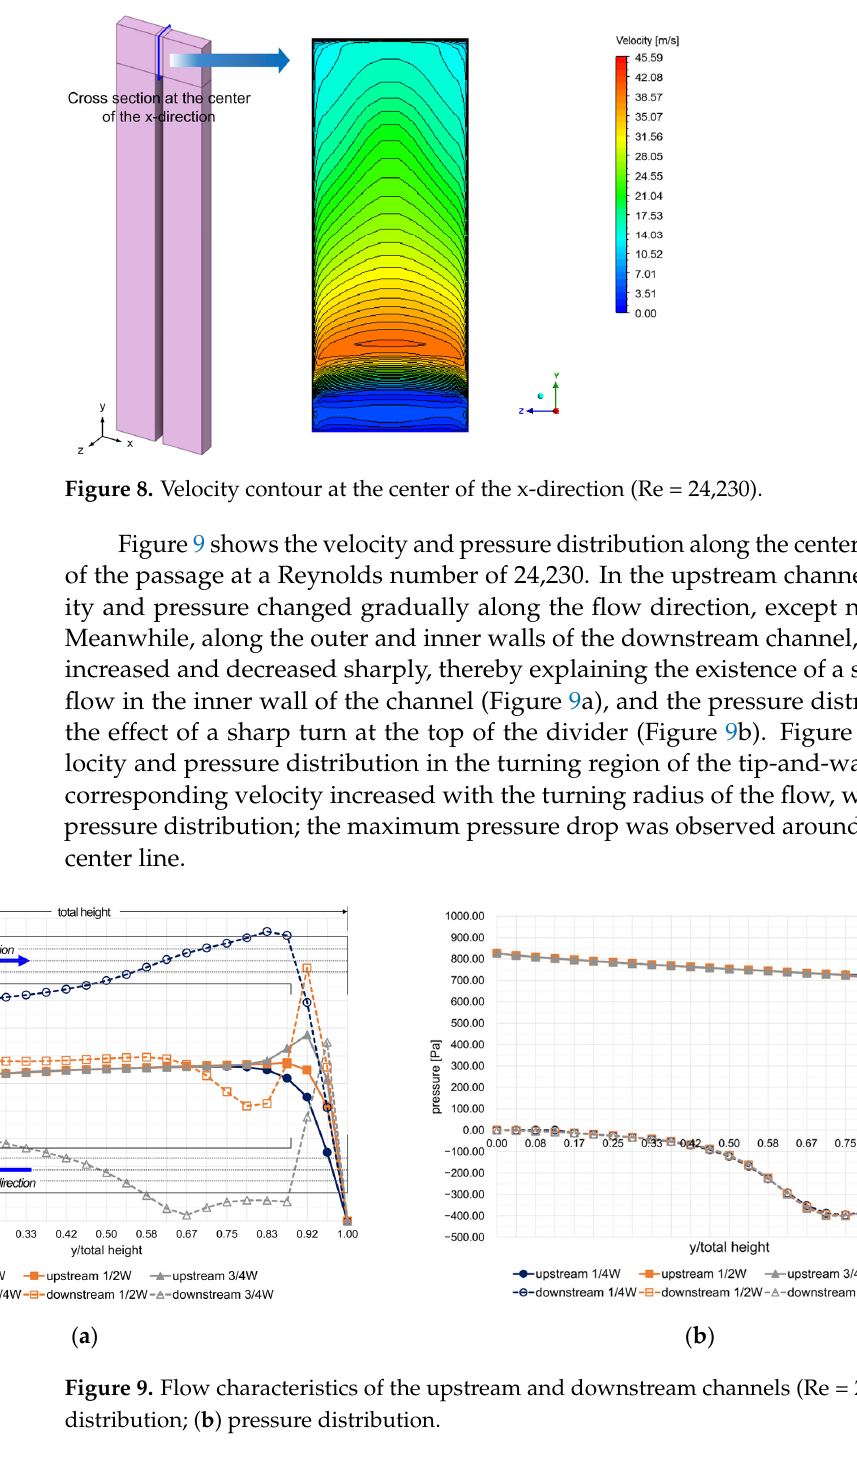
Figure 7. Velocity contour at di ff erent heights (Re = 24,230).